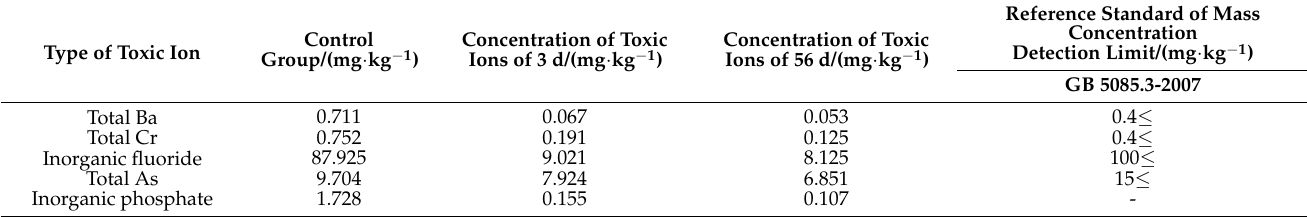
Table 7. Leaching toxicity test results.